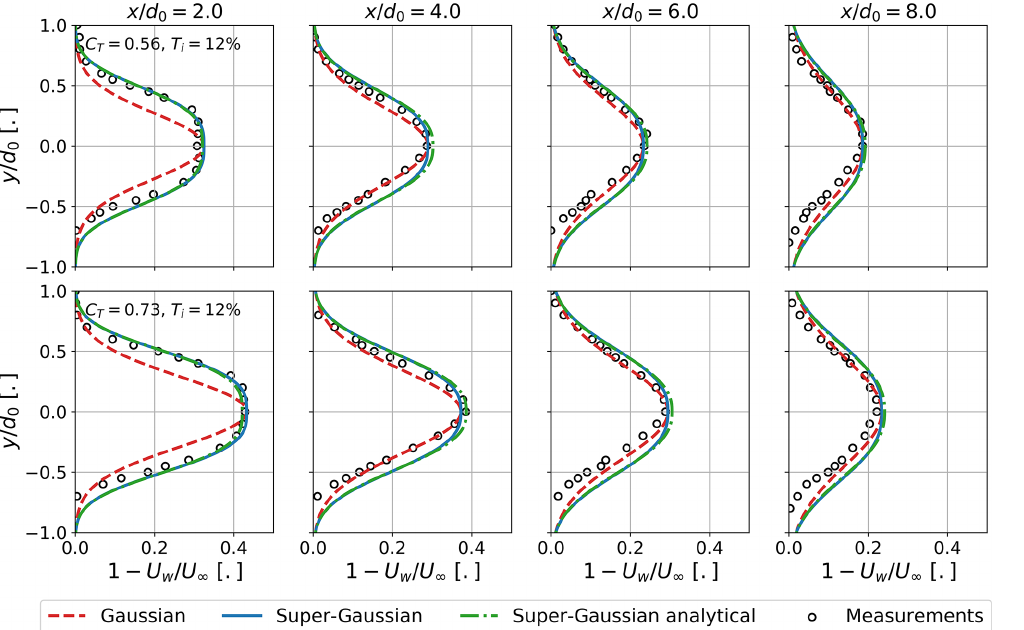
Figure 4. Normalized velocity deficit at four axial distances behind the actuator disk. High-turbulence